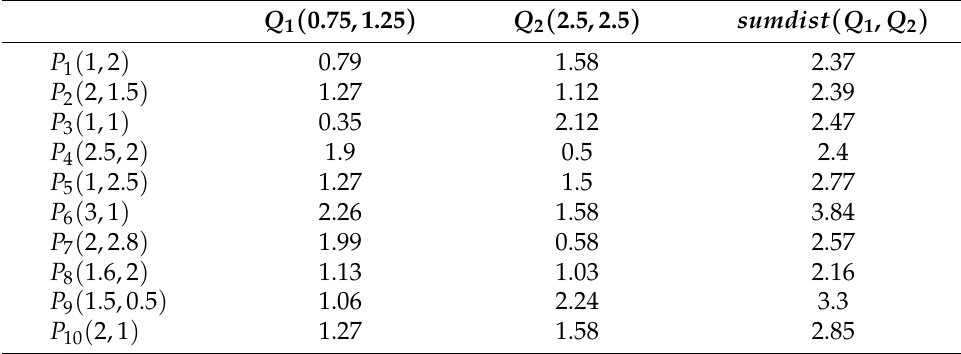
Table 3. Distance